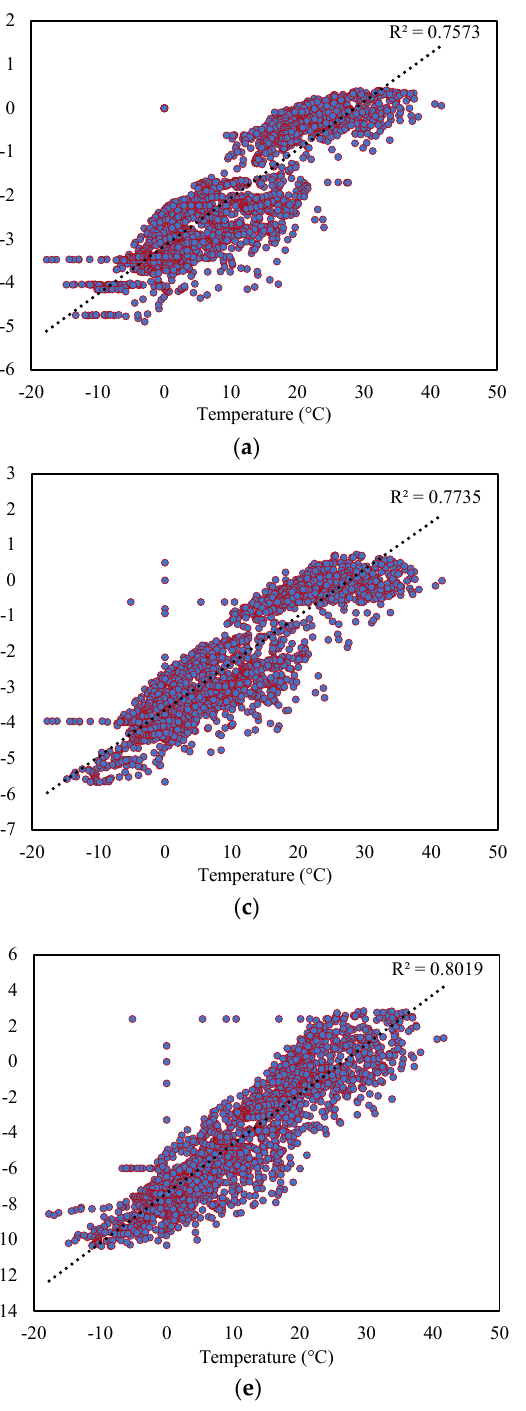
Figure 11. LVDT Monthly Ave. Relative to Temperature.